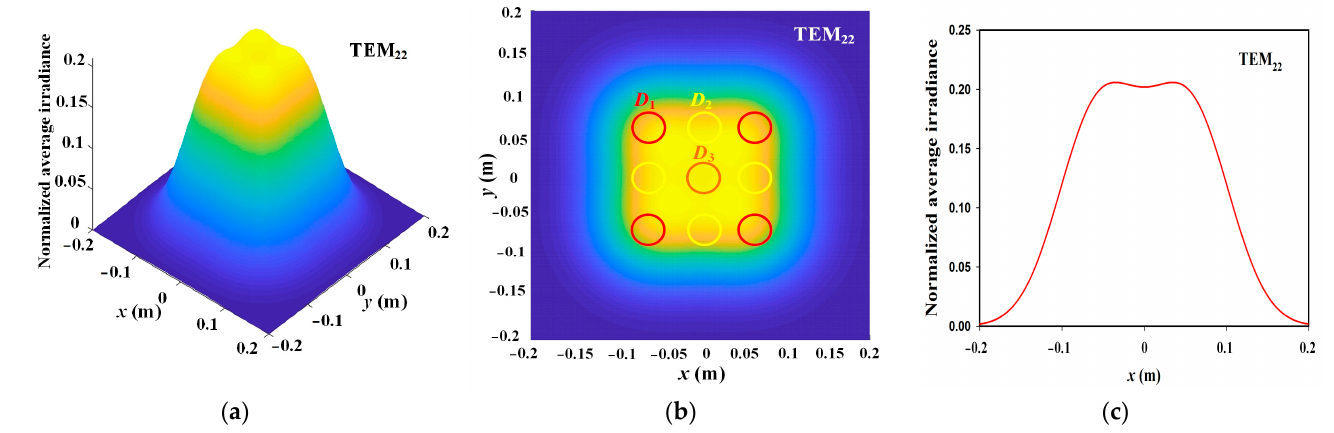
Photonics 2022 , 9 , x FOR PEER REVIEW 14 of 16 σ = 12.67 μ rad. ( a ) A 3D diagram, ( b ) a Figure 9. Average irradiance of TEM 22 HG beam when r Figure 9. Average irradiance of TEM22 HG beam when σ r = 12.67 µ rad. ( a ) A 3D diagram, ( b ) a vertical diagram and ( c ) a cross-section along the x axis. vertical diagram and ( c ) a cross-section along the x axis.